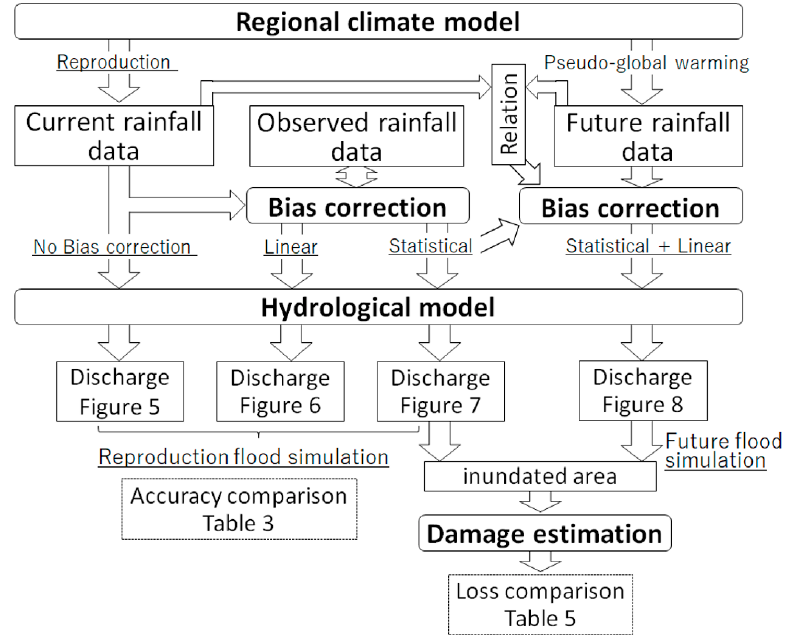
Figure 4. Data flow for all of the procedures.